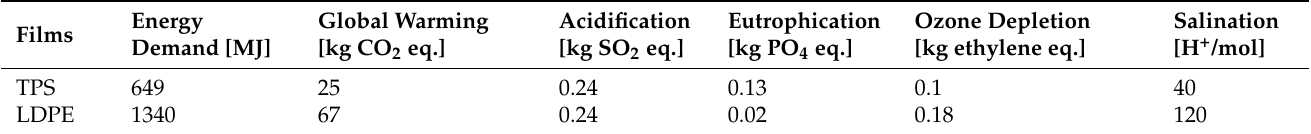
Table 6. The LCA results for TPS and LDPE (Dinkel et al., [130] & Patel et al.,